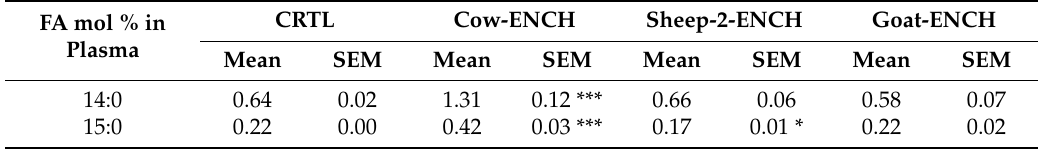
Figure 2. Relative PPAR- α gene expression in the buffy coat of subjects consuming 1.5 g/day of FO and 90 g/day of sheep-1-ENCH cheese for two and four weeks. The data are expressed as mean ± SEM, with 15 individuals per group; ** p < 0.01; versus baseline (time 0). Table 2 outlines the plasma FA levels in subjects ingesting ENCH cheeses (50 g per day) from different sources. Table 2. Main FA in the plasma of subjects consuming 50 g/day of different types of ENCH cheese for two months. The cheeses were produced from the milk of cows (cow-ENCH), sheep (sheep-2-ENCH) and goats (goat-ENCH). PA, palmitic acid; OA, oleic acid; ALA, α -linolenic acid; EPA, eicosapentaenoic acid; DHA, docosahexaenoic acid; LA linoleic acid, ARA, arachidonic acid; VA, vaccenic acid and CLA, conjugated linoleic acid. The data are expressed as mol % and represent mean ± SEM of 36 individuals per group; * p < 0.05; ** p < 0.01; *** p < 0.001 versus control (CRTL) group. CRTL FA mol % in Plasma